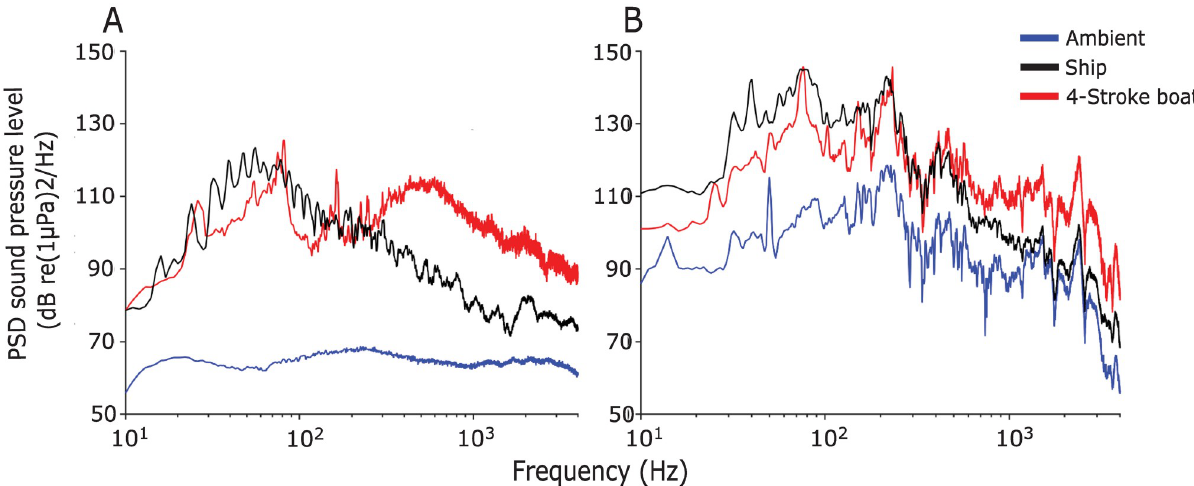
Fig 3. Power spectral densities (PSD) of acoustic treatments. Power spectral densities of (A) field and (B) playback of acoustic treatments. Mean PSD values were calculated from three individual samples of each noise source (Window type: 1 s Hamming, 50% overlap, frequency resolution of 1Hz). Duration of ambient, ship and 4-stroke boat playback samples for the sound analysis were approximately 30, 8 and 30 s.